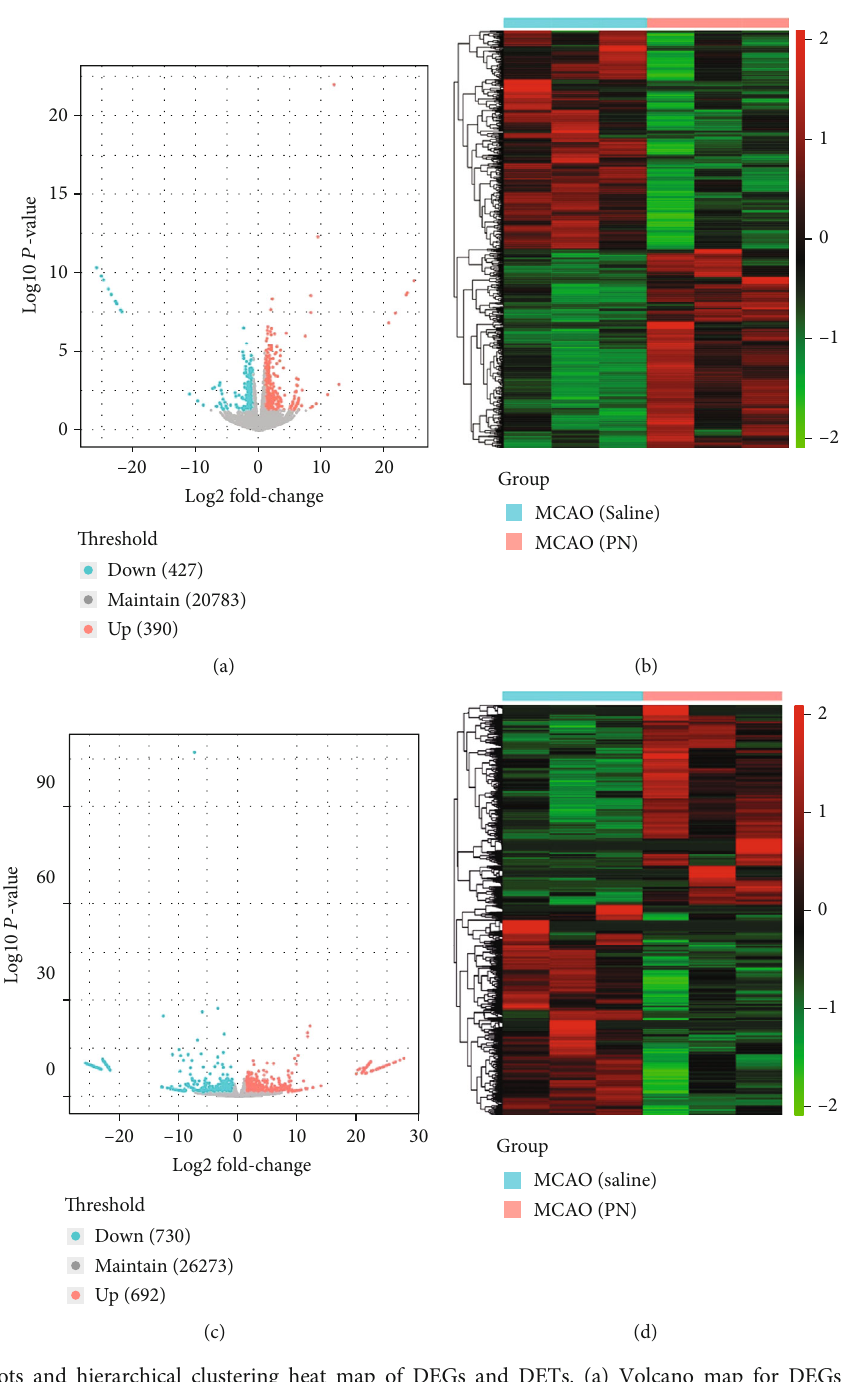
Figure 4: Volcano plots and hierarchical clustering heat map of DEGs and DETs. (a) Volcano map for DEGs where red represents upregulated genes and green represents downregulated genes. (b) Heat map for hierarchical clustering of DEGs. (c) Volcano map for DETs, red represents upregulated transcripts, and green represents downregulated transcripts. (d) Heat map for hierarchical clustering of DETs). n = 3 in each